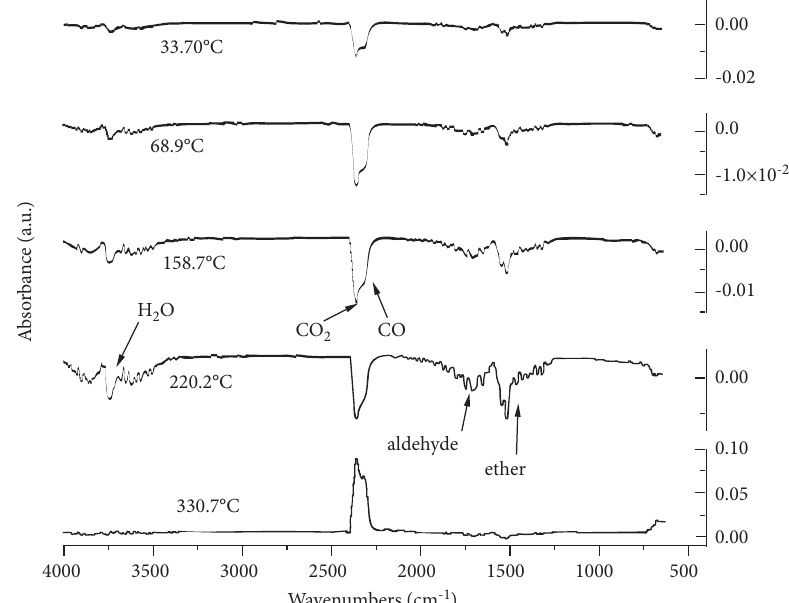
Figure 10: IR spectra of gas products for the Bulianta 12# raw coal sample at characteristic temperatures (cf. Table 2).